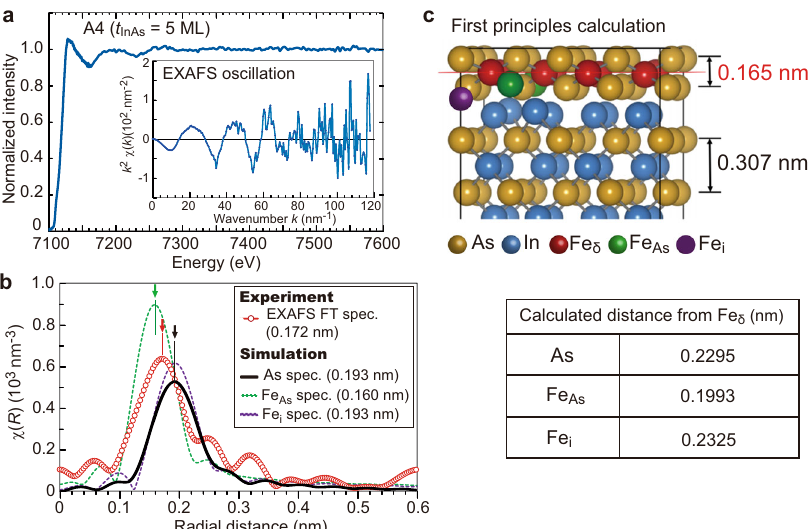
Fig. 6 Local structure around Fe atoms. a X-ray absorption fi ne structure (XAFS) spectrum at the Fe K-edge, measured in sample A4 ( t InAs = 5 MLs). Inset shows the extended X-ray absorption fi ne structure (EXAFS) oscillation component extracted from the XAFS spectrum. Here, the EXAFS oscillation is weighted by wavenumber k 2 . b The red curve with white circles shows the Fourier transformed (FT) spectrum of the experimental k 2 -weighted EXAFS oscillation shown in ( a ) as a function of atomic distance. Black curve is the spectrum simulated from the nearest As atoms in the FeAs monolayer, whose lattice in the z direction shrinks as mentioned in ( c ). Green and purple dotted curves are the spectra simulated from the two Fe disorder positions, As- antisite Fe (Fe As ) and octahedral interstitial Fe (Fe i ), respectively, using the atomic distances obtained by our fi rst principles calculation. The peak position of each curve is pointed by an arrow and provided in the legend. c First principles calculation with the VASP code shows that the thickness in the z direction of the FeAs layer shrinks to 0.165 nm, which is only 54% of that (0.307 nm in our calculations) in the InAs layers. Atomic distances from an Fe atom in the lattice site (Fe δ ) to the nearest As, Fe As , and Fe i atoms are also shown in the